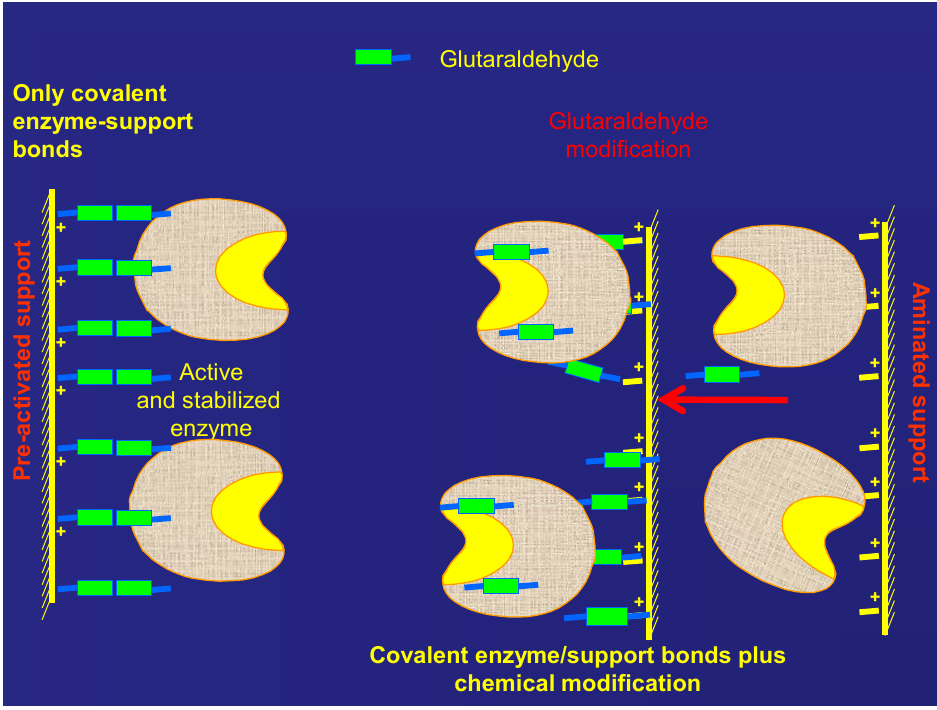
Scheme 1. Schematic representation of the versatility of glutaraldehyde.